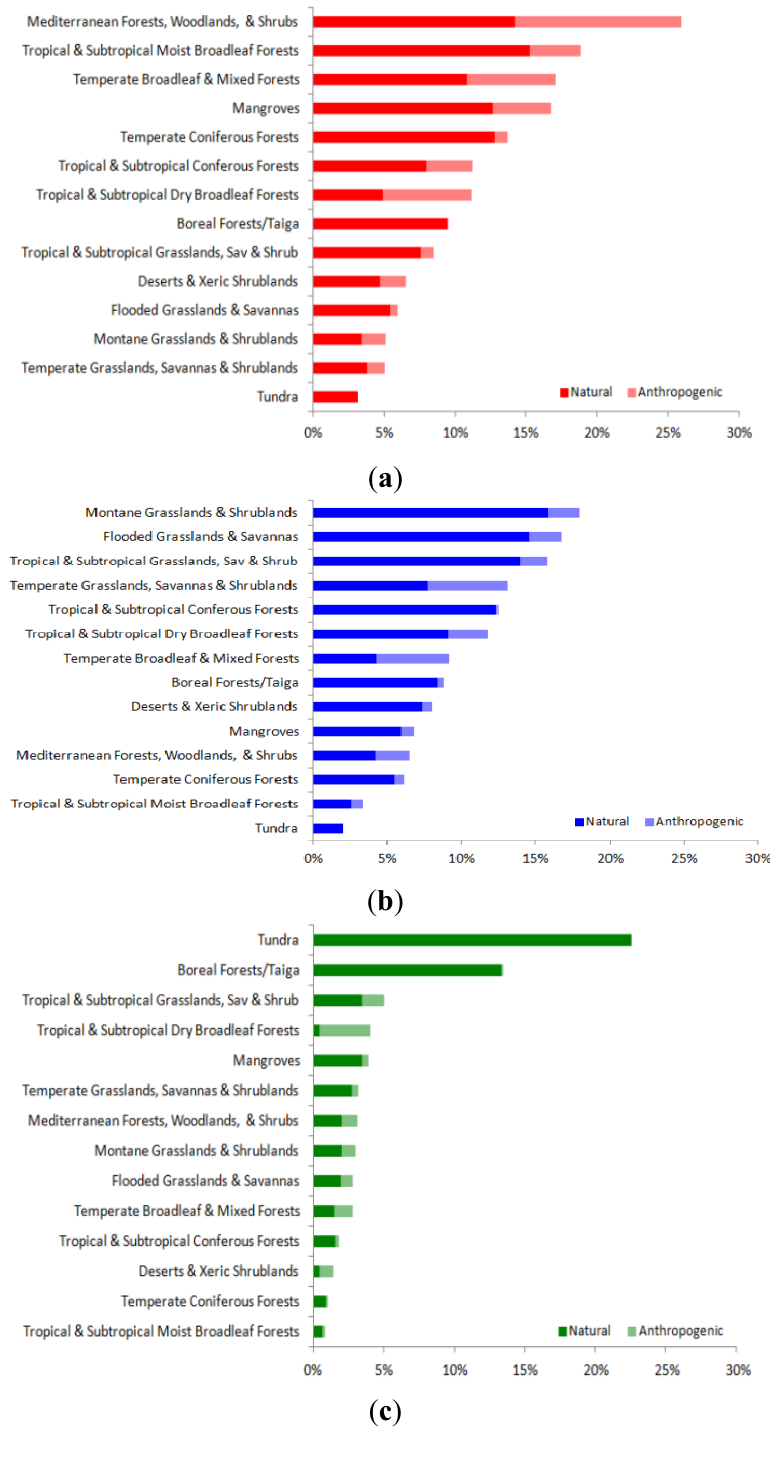
Figure 3. ( a ) Proportion of each biome affected by Class 1, both of natural (dark red) and anthropogenic (light red) origin. ( b ) Proportion of each biome affected by Class 2, both of natural (dark blue) and anthropogenic (light blue) origin. ( c ) Proportion of each biome affected by Class 3, both of natural (dark green) and anthropogenic (light green)